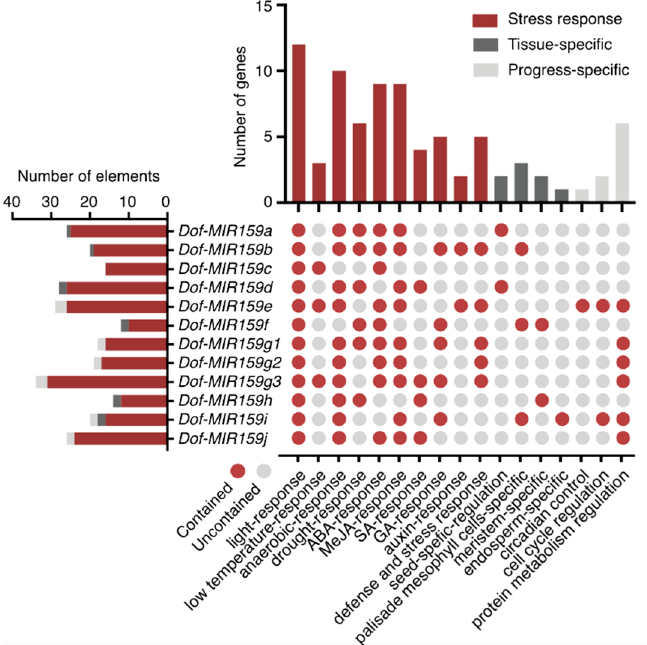
Figure 3. Prediction of cis -acting elements on the promoter of MIR159 gene family in D. officinale . The image at left showed the number of cis- acting elements in the promoter region of Dof-MIR159 genes. The image at middle showed the elements contained in the promoter of Dof-MIR159 genes. The upper image showed the number of Dof-MIR159 genes containing cis- acting elements related to 3 classes, including stress response (marked with red), tissue-specific (marked with dark grey), and progress-specific (marked with light grey).